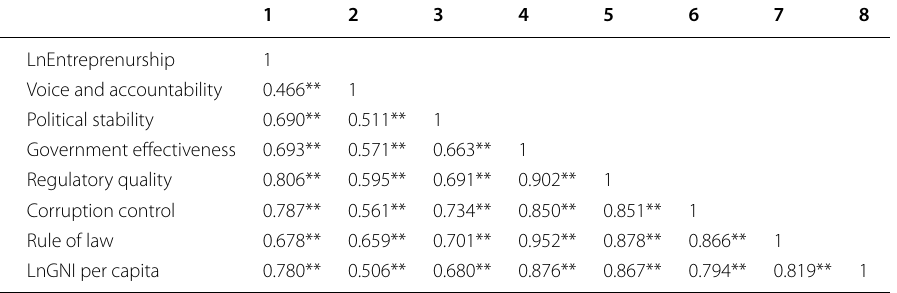
Level (two-tailed), N